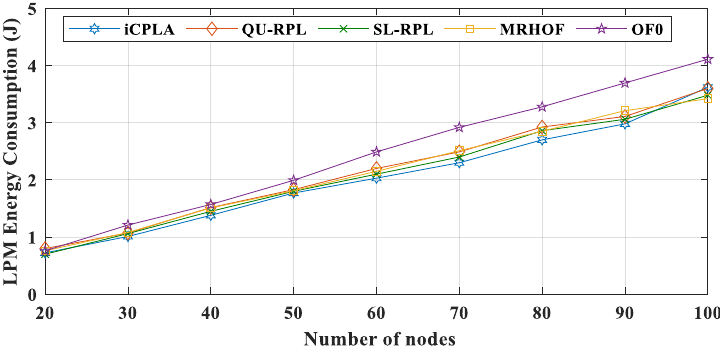
Figure 12. Comparison of LMP energy consumption (J) between i CPLA, QU-RPL, SL-RPL, MRHOF, and OF0 with 𝛼 = 0.3 and 𝛽 = 0.7 in a network of 20 to 100 nodes.